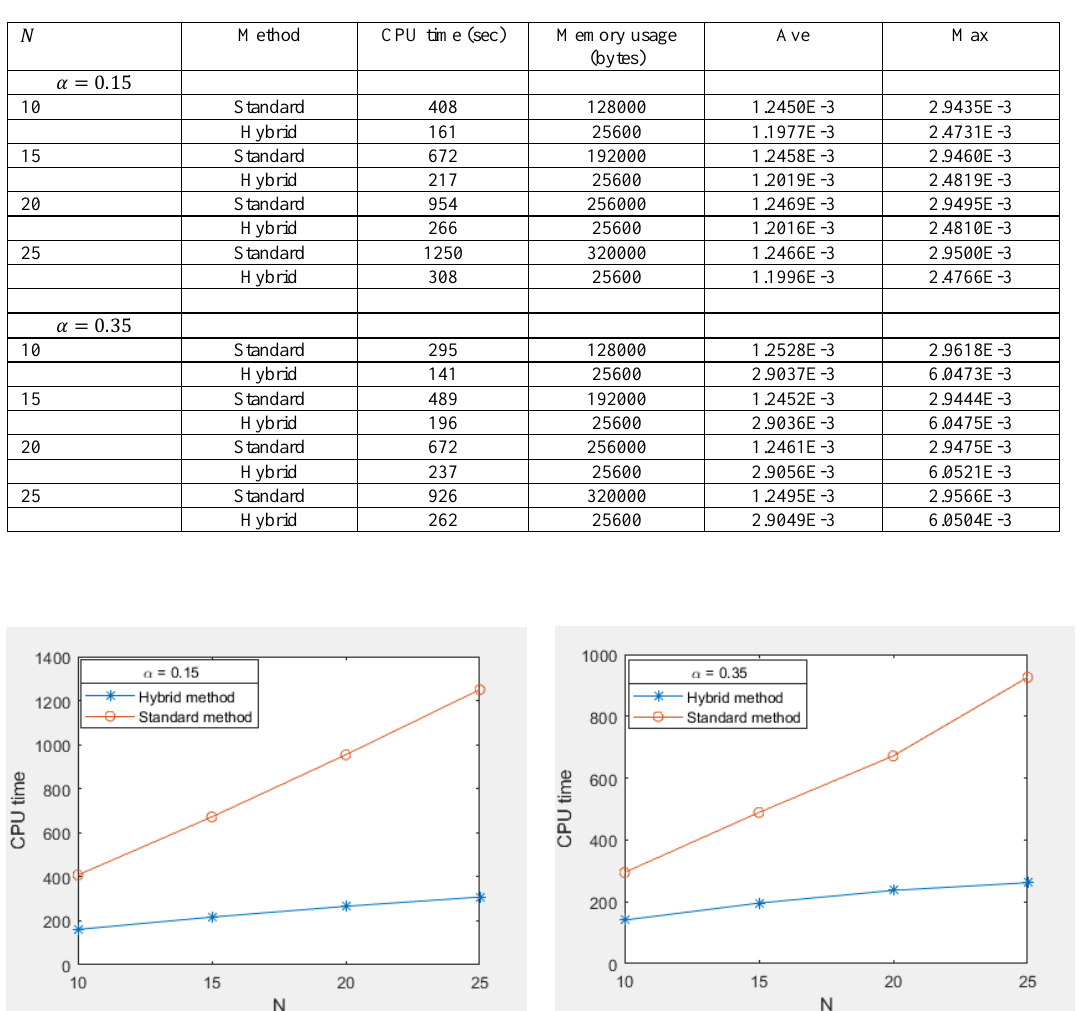
= ℎ = 1/40 for Example 1 𝑥 𝑦